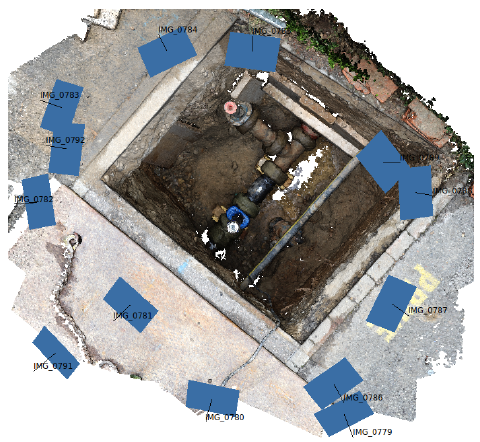
Figure 4: 3D reconstruction of pipeline objects based on images from multiple